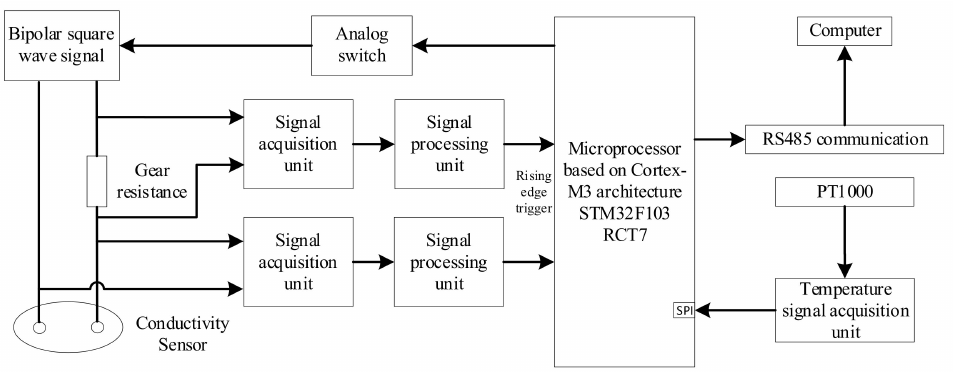
Figure 4. Overall structure of the